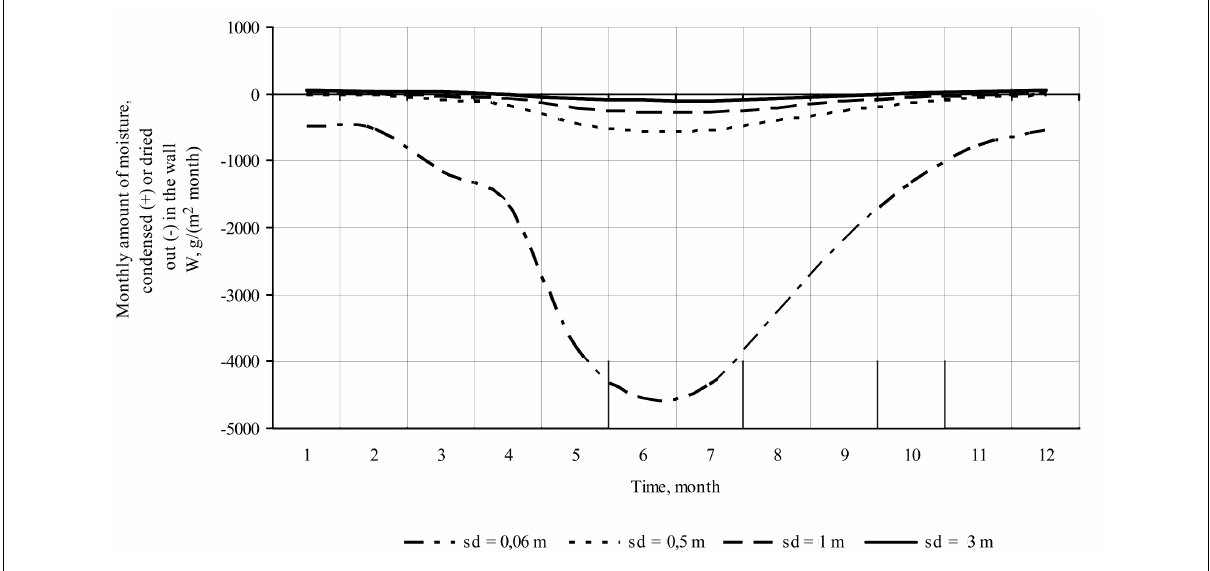
Fig 6. Annual dynamics of moisture alteration in the wall in its possible zone of condensation when the thickness of the air layer equivalent to the material’s water vapour permeability s d